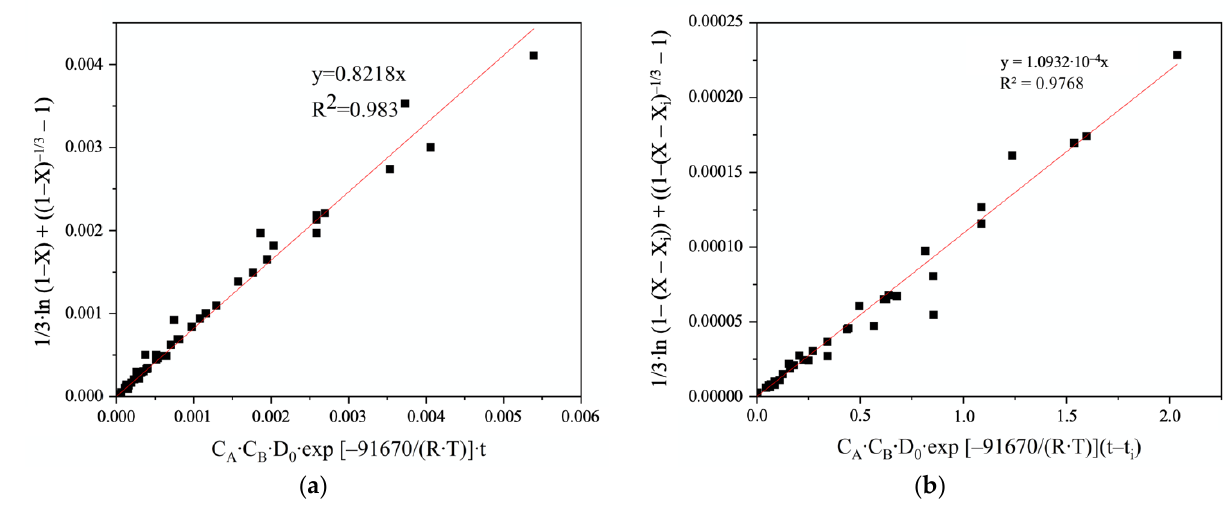
Figure 17. Relationship between SCM equation and k 0 · C 1 · C 2 · D 0 · exp [ − E d /(R · T)] · t in the hydrothermal treatment of FeAsS